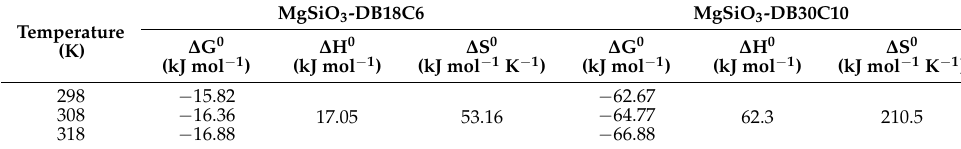
Table 6. Thermodynamic parameters for Pd(II) adsorption onto